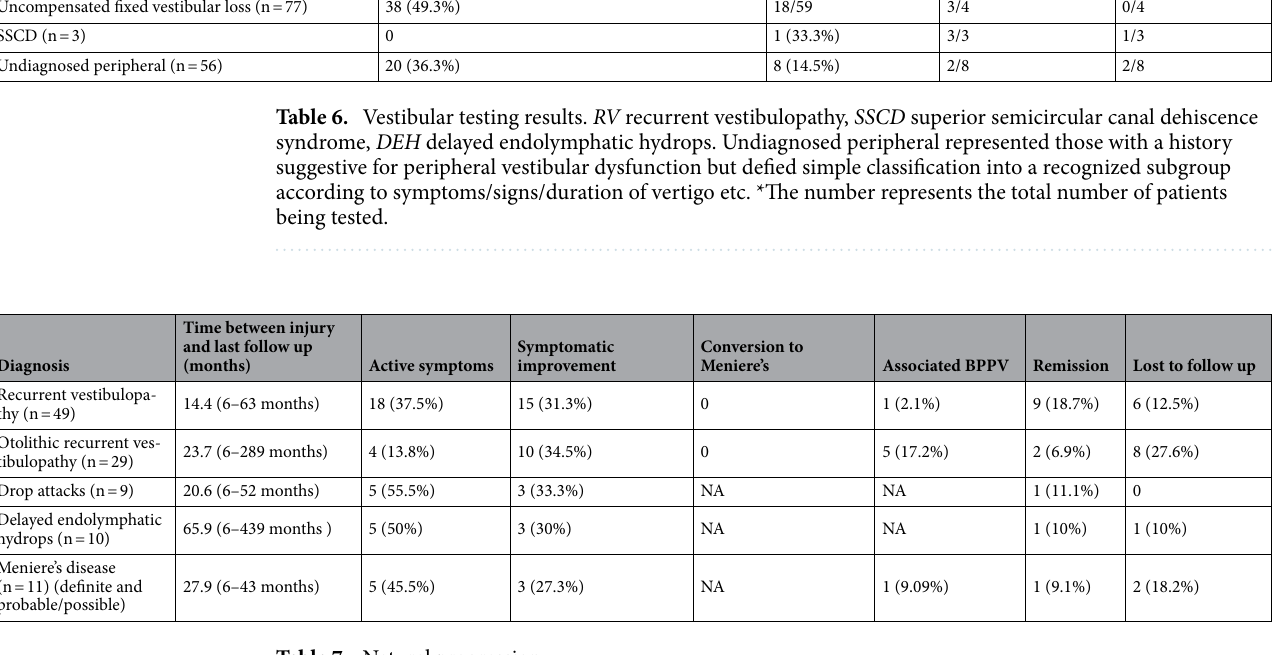
Table 7. Natural